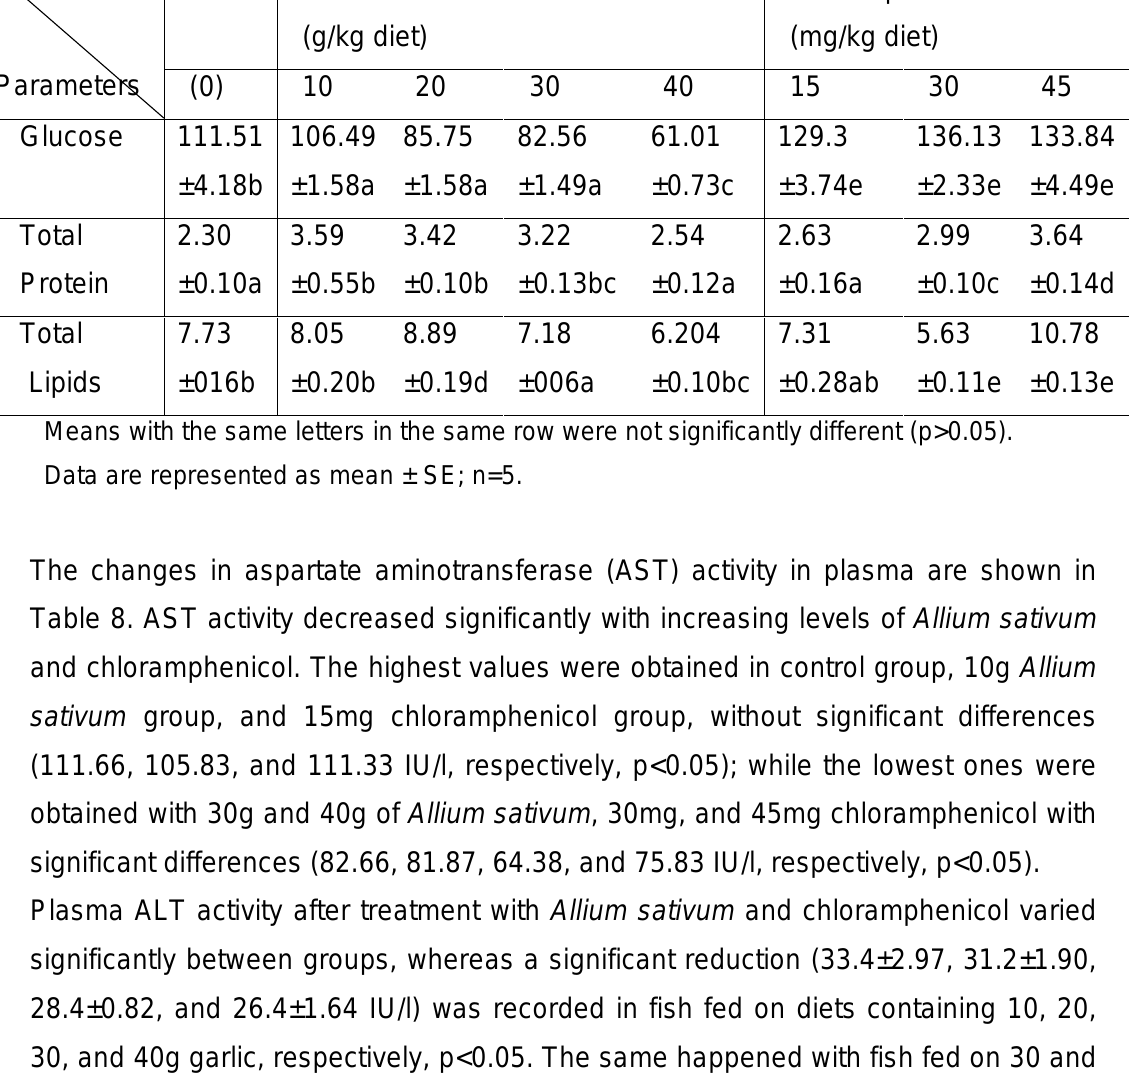
Table 7: Changes of glucose concentration (mg/l), total protein (g/100), and total lipids (g/l) in the blood of O. niloticus fed on diets containing different levels of Allium sativum and chloramphenicol. Control Allium sativum levels Treatments (g/kg diet)